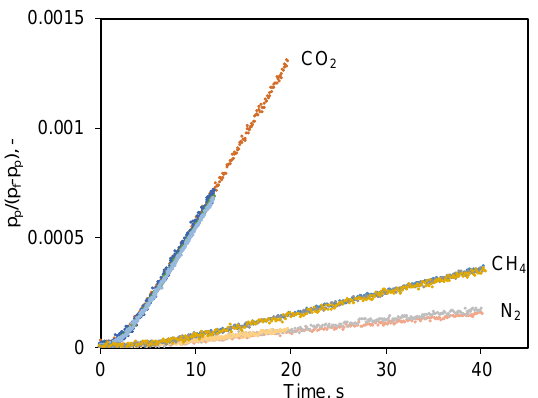
Figure 5. “Time-lag” curves for CO 2 , CH 4 and N 2 obtained for the sample of PTMSP, containing 5 mol% butylimidazole bromide units. The vertical axis represents the value of permeate pressure normalized by the driving force (p f − p p ) for each acquired data point.